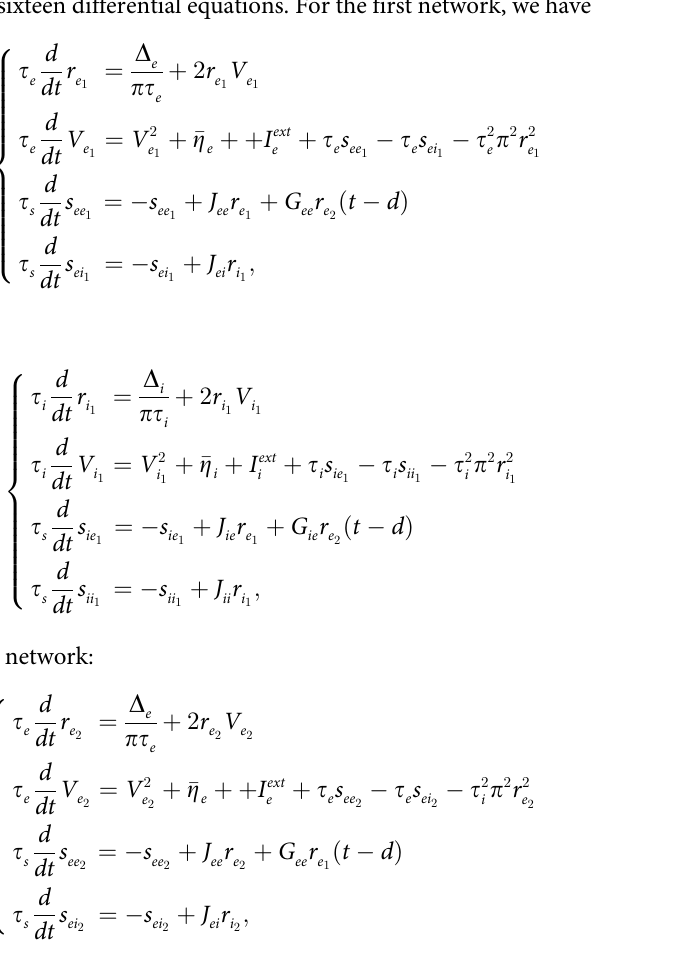
= N = 5000; τ = τ = 10; τ = τ = 1; e i e i se si